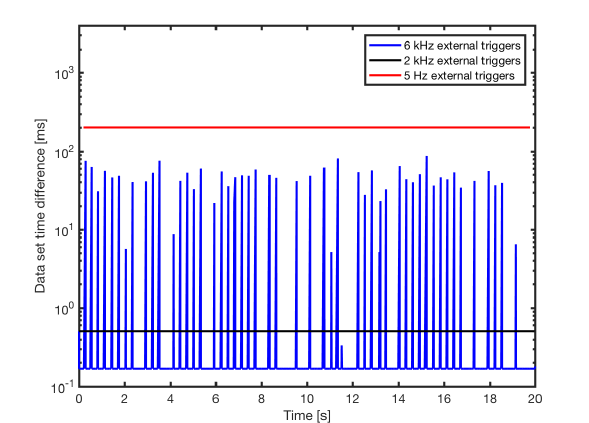
Figure 10. Characterization of the maximum scattering data acqui- sition rate of PHIPS-HALO in the case of simultaneous image ac- quisition at 3Hz. Note that the maximum rate without a simultane- ous image acquisition is